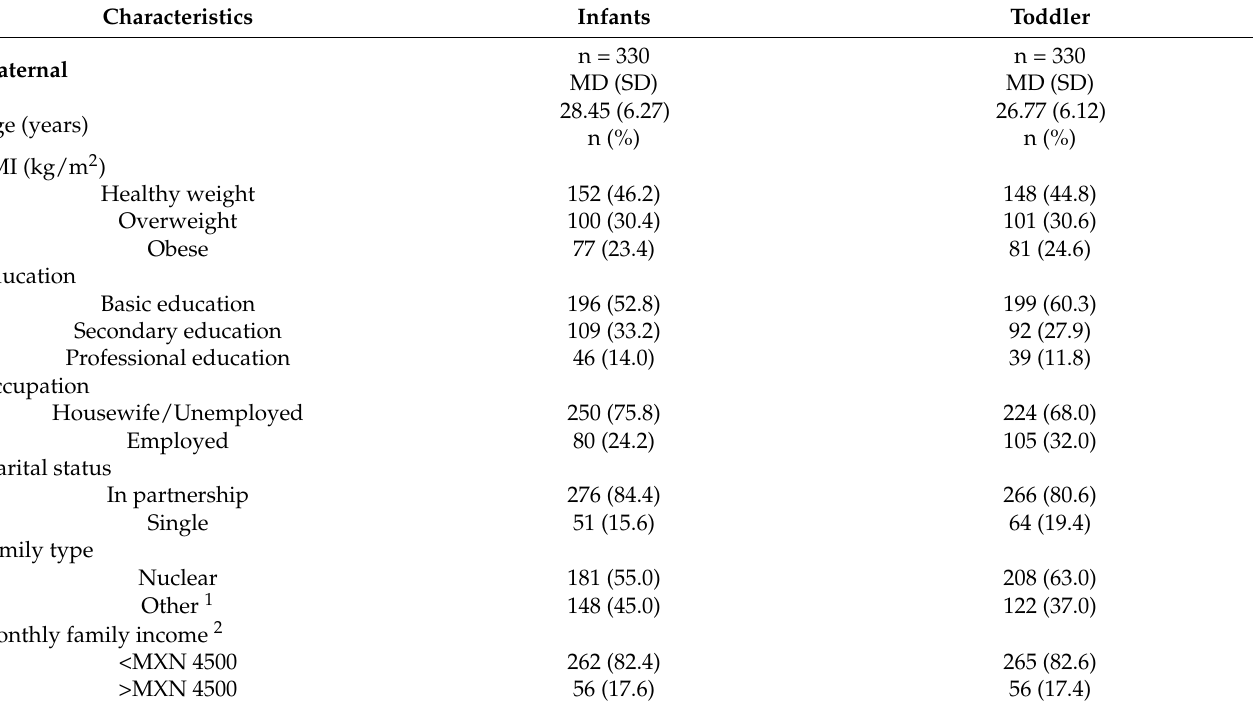
Table 1. Sociodemographic characteristics of infants (n = 330) and toddlers (n = 330) and their respective families.